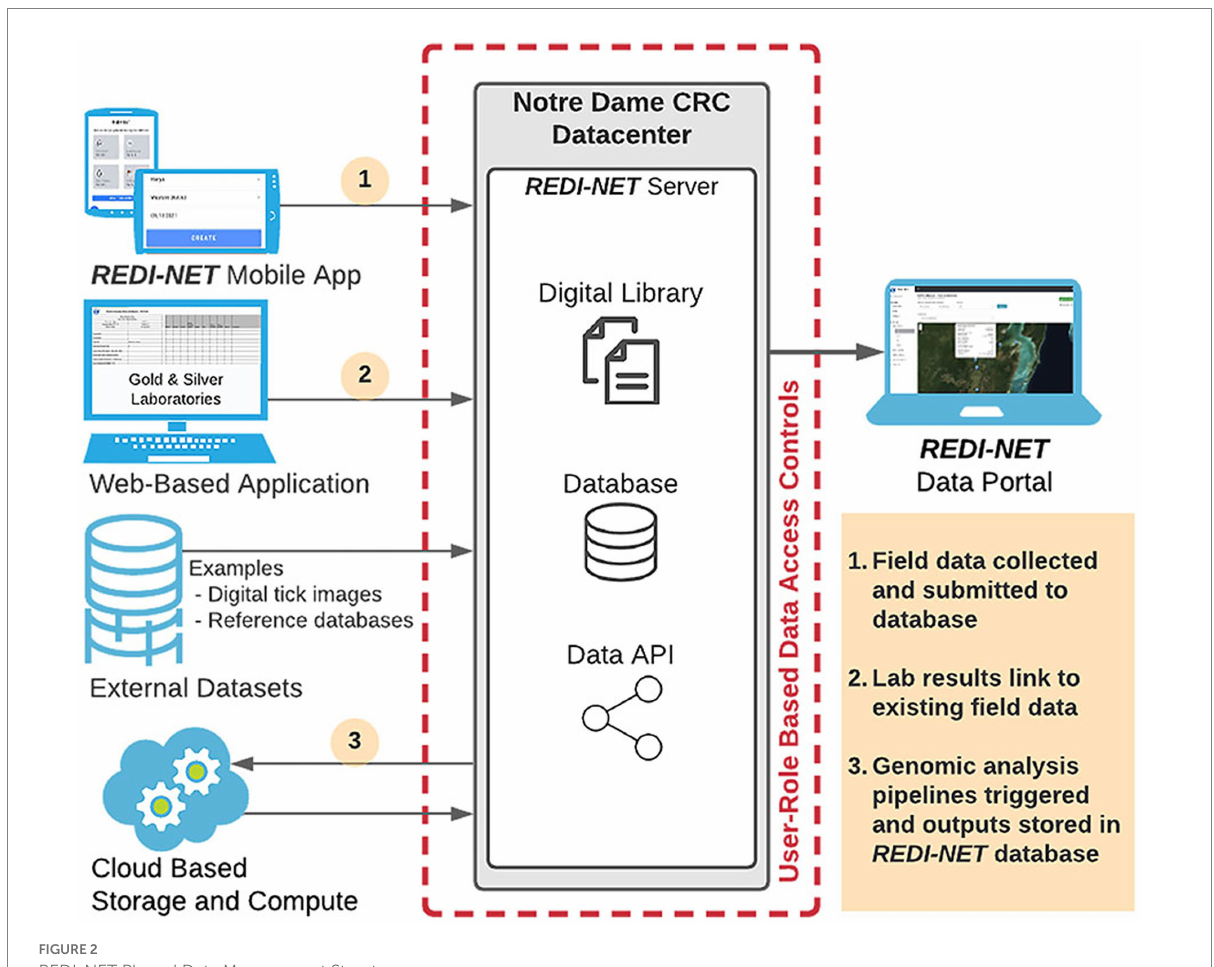
FIGURE 2 REDI-NET Phase I Data Management